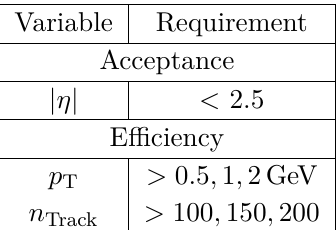
Table 1. Acceptance and efficiency requirements for a track-trigger targeting events with a high multiplicity of soft tracks.